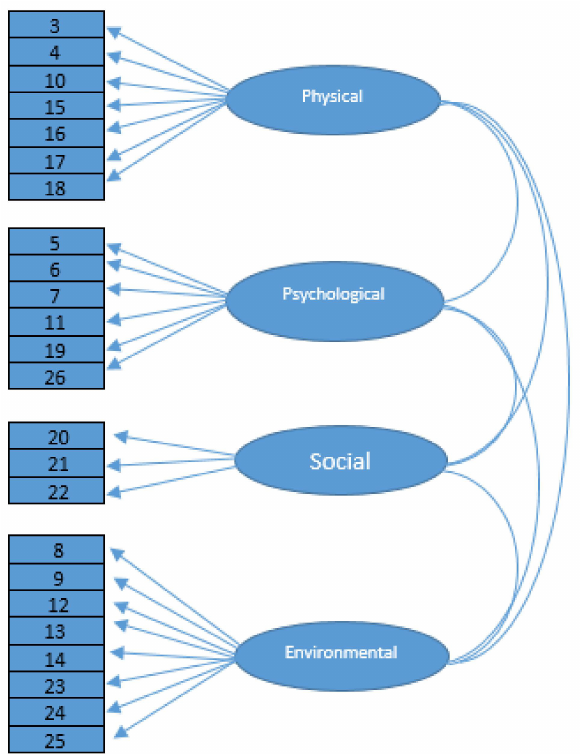
Figure 1. Measurement model